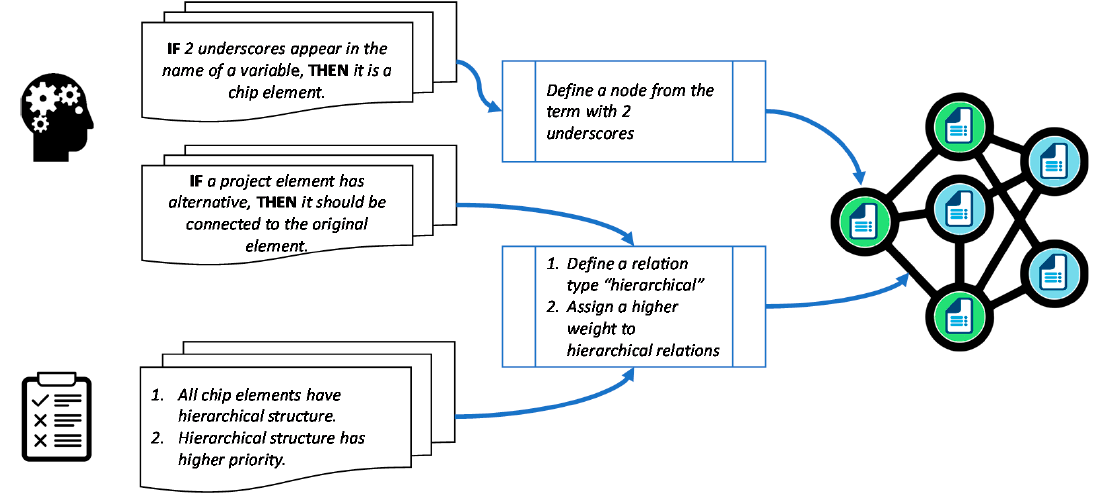
Figure 2. Example of integrating expert defined rules and domain requirements in the creation of graph nodes and relations. In the proposed framework, expert knowledge is used for defining the nodes and relations of the graph. Domain requirements are here presented as a list, which is used by the relation extraction algorithm to define graph relations.